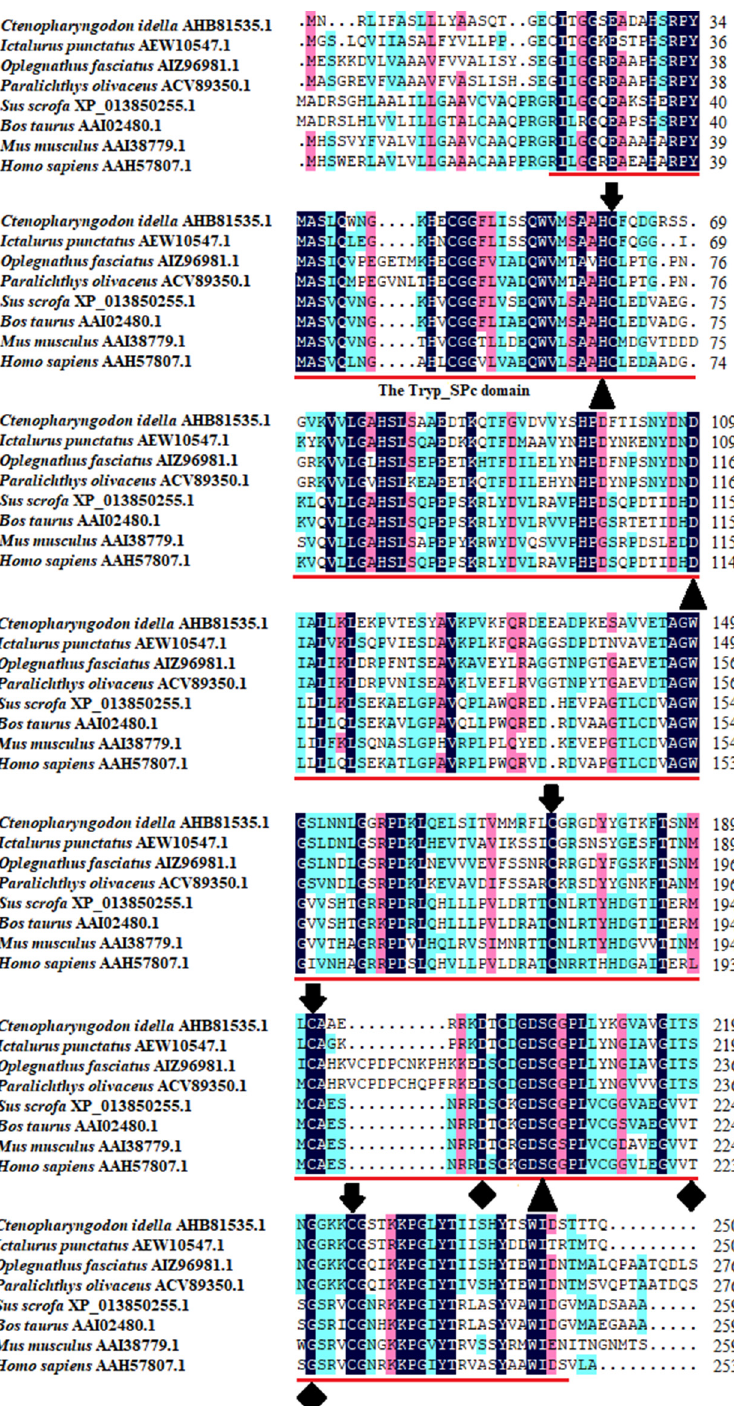
Figure 2. Multiple sequence alignments of Ci Df with other vertebrates. The amino acid residues shaded in dark are conserved sites, and the functional domain is underlined in red. The critical residues of catalytic sites (serine protease active sites), the substrate-binding sites, and residues probably involved in disulfide pairing are indicated as solid triangles, solid diamonds, and solid arrows, respectively.